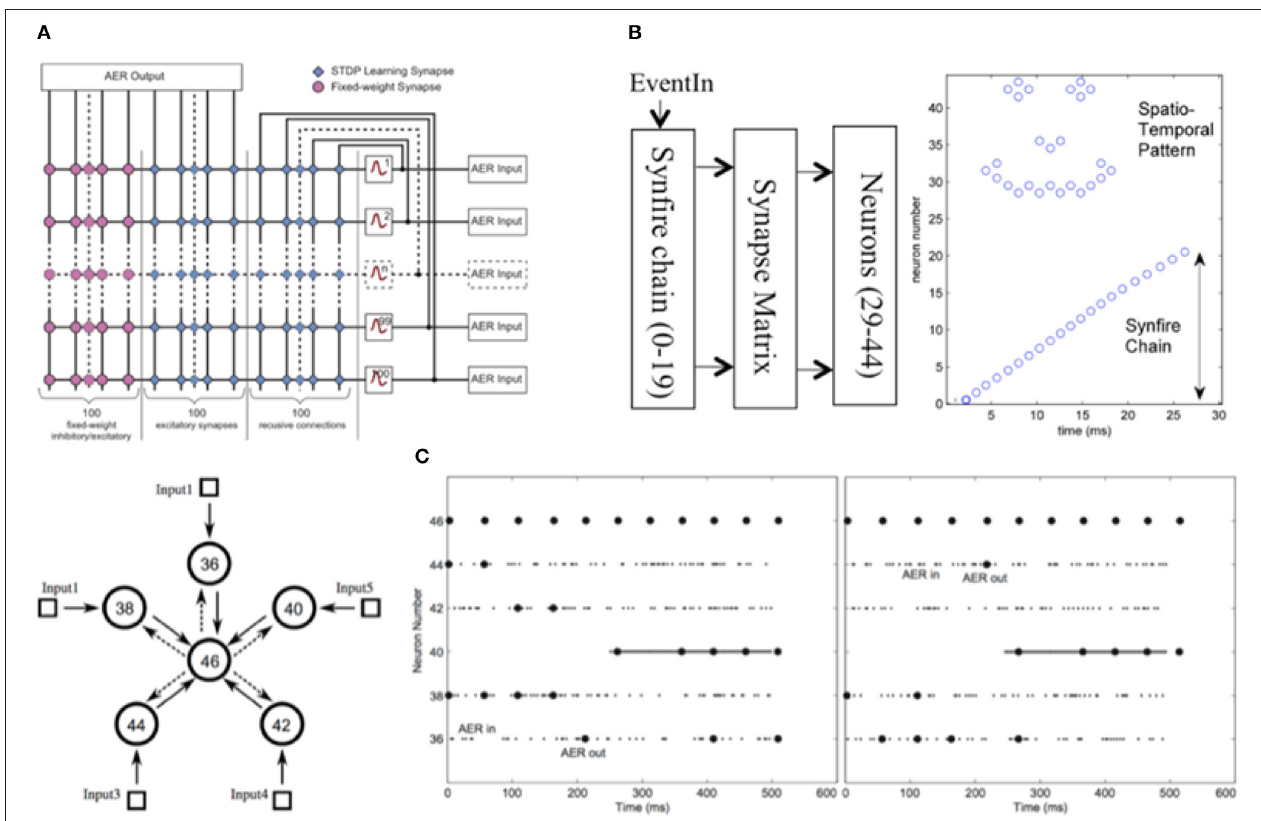
FIGURE 26 | Neuron IC built from transistor-channel-modeled components. (A) The IC uses a mesh-type structure of synapses, an array of configurable elements to compile the desired soma dynamics, and AER blocks that output action potentials into the synapse fabric as well as AER blocks that that input action potentials from soma blocks, 10,000 STDP excitatory learning enabled synapses connected in recurrent connections, 10,000 STDP excitatory learning enabled synapses connected from AER, and 10,000 programmable (fixed-weight) excitatory or inhibitory synapses connected from AER. (B) Measured synfire neuron chain activating other programmed neurons. (C) Diagram and experimental measurements of a spiking Winner-Take-All (WTA) network drawn as a ring topology. The network is a combination of input neurons on the outside part of the ring, and an interneuron, which provides the negative feedback through inhibitory neurons, for the WTA computation. This work labels the particular neurons used for this experiment, and all synapses used are programmable synapses, whether excitatory or